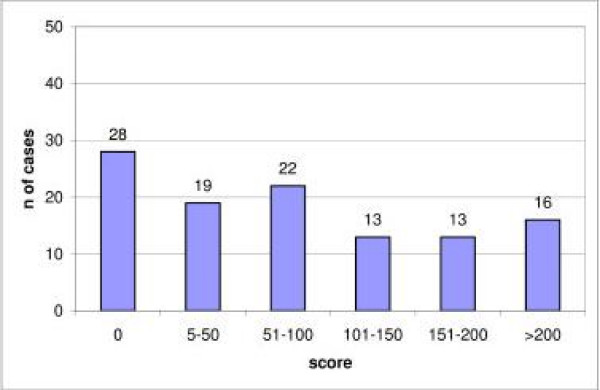
Distribution of AR score values in 111 breast carcinomas.